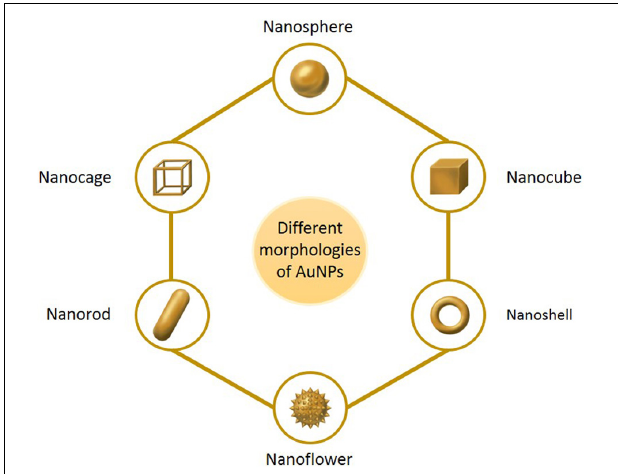
FIGURE 1 | The main morphologies of AuNPs.